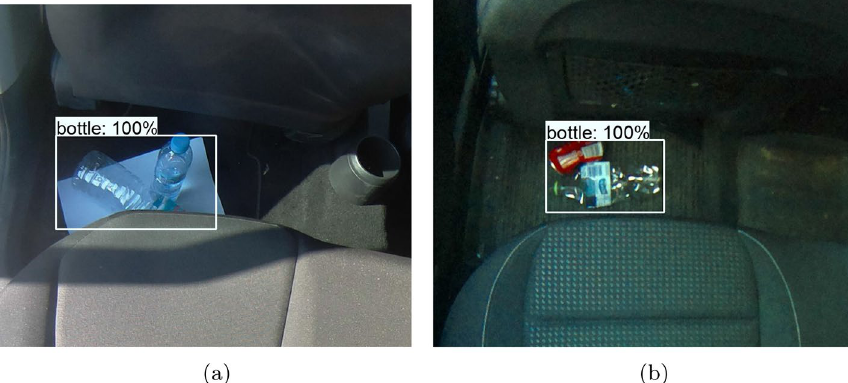
Fig. 27 Two instances of the bounding box merging for items placed in close proximity to each other. The image in a depicts items from the same trained class and the image in b depicts items from two different trained